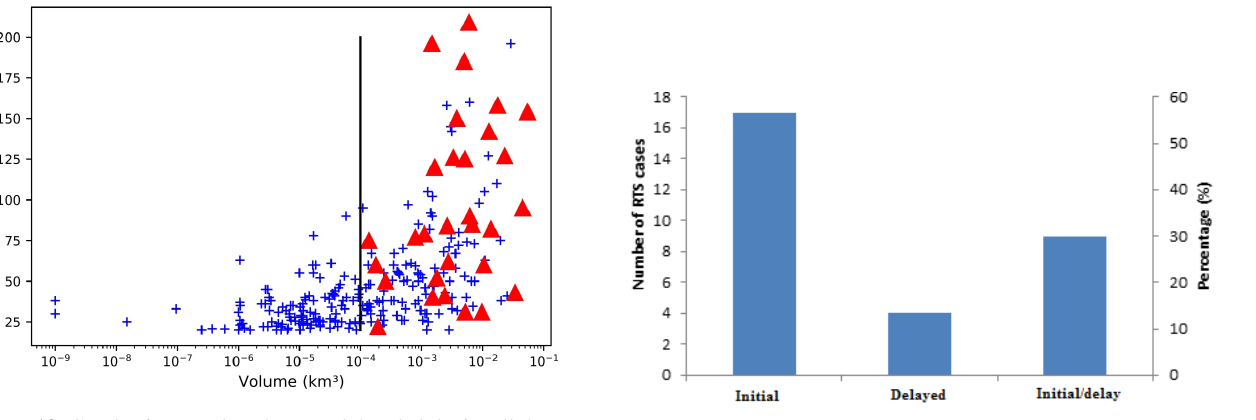
Figure 12. Graph of reservoir volume and dam height for all dams in Brazil. The triangles indicate the RTS cases and the crosses other reservoirs. The black bar is the limit of RTS cases. Figure 13. Graph of the type of response for RTS